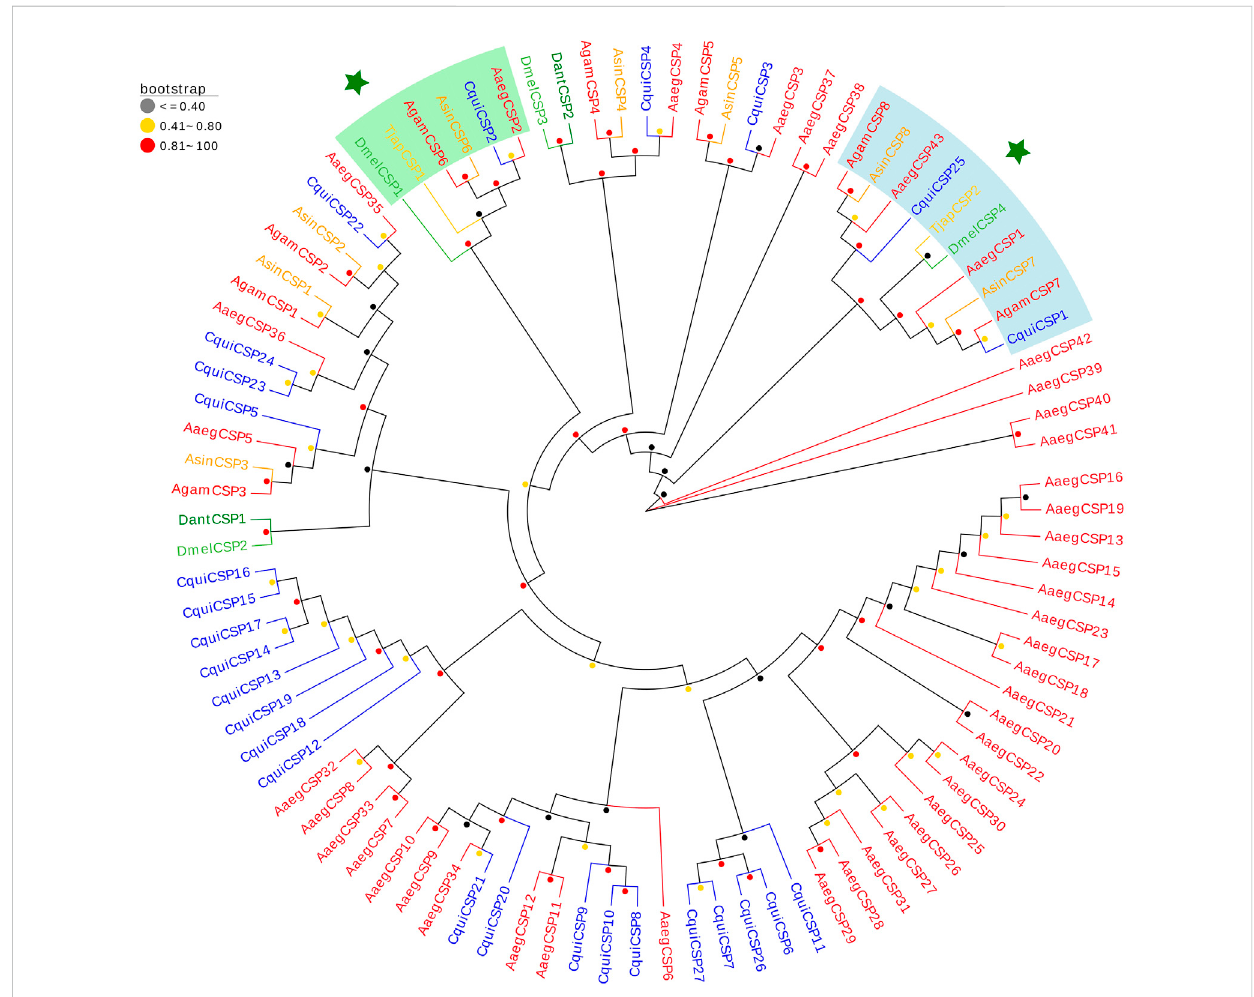
FIGURE 2 The NJ phylogenetic analysis of CSPs in T. japonensis , C. quinquefasciatus , D. antiqua , A. aegypti , A. gambiae , A. sinensis and D. melanogaster . Two TjapCSPs clustered into two groups are shown. The TjapCSP1 and TjapCSP2 were marked with